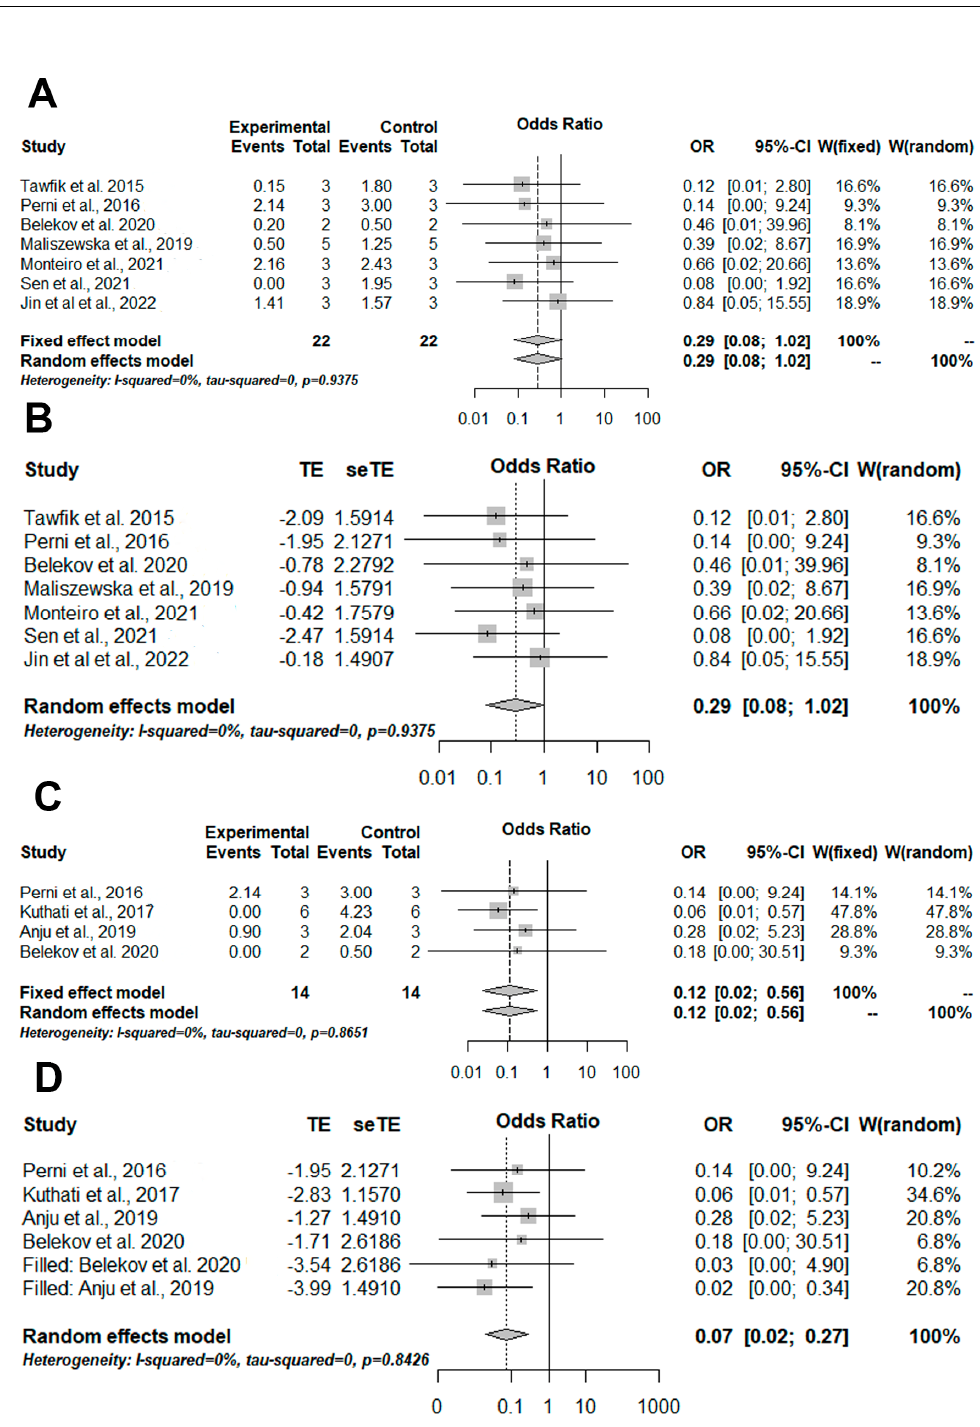
Figure 5. Illustration of meta-analysis and quantitative approaches. The experimental group was formed by aPDT mediated by photosensitizers conjugated inorganic nanoparticles and the control group was formed by aPDT only. ( A ) The results of the meta-analysis illustrated in a forest plot for the viability of Gram-positive bacteria cultivated in suspension. ( B ) Trim-and-fill results for the viability of Gram-positive bacteria cultured in suspension show the absence of publication and meta-analysis biases. ( C ) The results of the meta-analysis illustrated in a forest plot for viability Gram-negative bacteria cultivated in suspension. ( D ) Trim-and-fill results for Gram-negative bacteria cultivated in suspension presence of publication and meta-analysis biases. OR = odds ratio; CI = confidence interval; W: weight. TE = estimated mean; seTE = estimated standard deviation [29– 31,33,34,36,38,40,41].